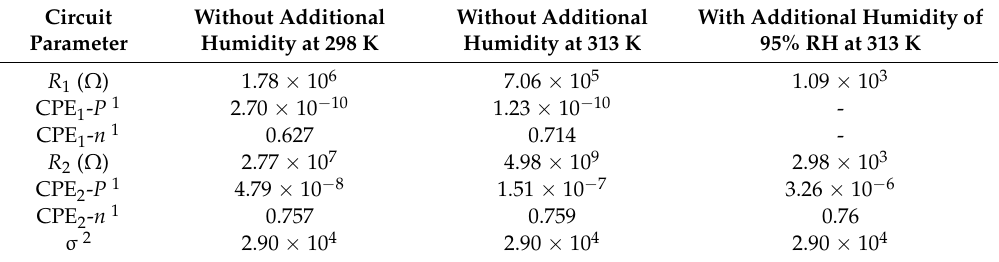
Table 4. Estimated parameters with the equivalent circuit for CP-MAImC 1 -PW 12 /MAImC 8 Br (1:1). Circuit